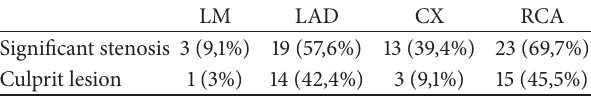
Table 1: The clinical data of 33 patients with STEMI. STEMI anterior